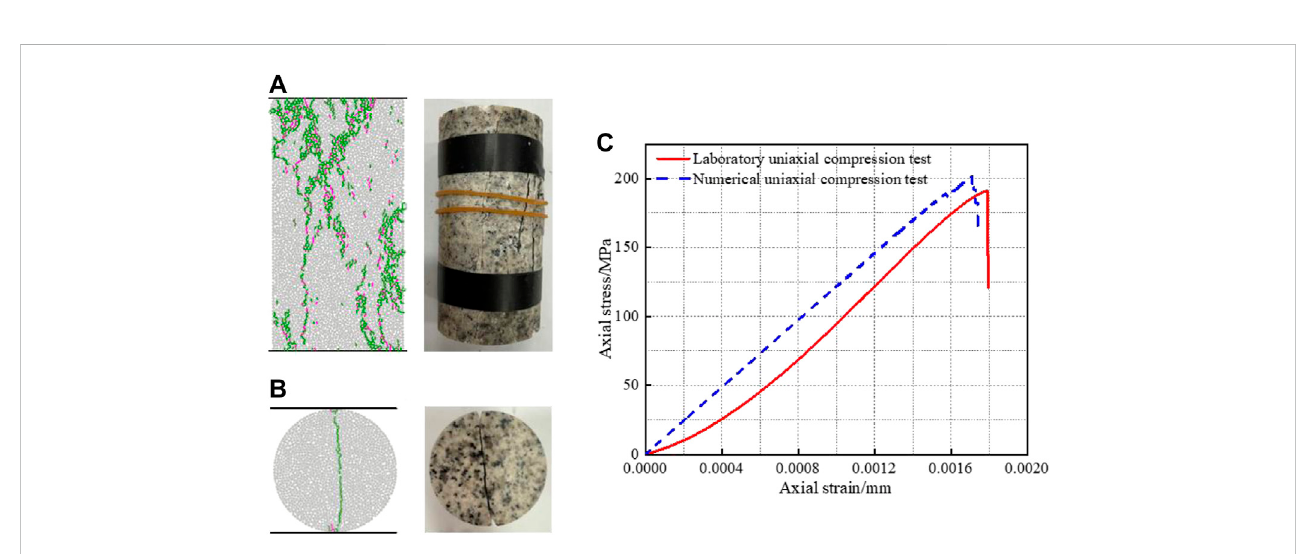
FIGURE 3 Comparison of indoor test and simulation results (A) . Uniaxial compression test (B) . Brazilian splitting test (C) . Axial stress-strain curve of uniaxial compression